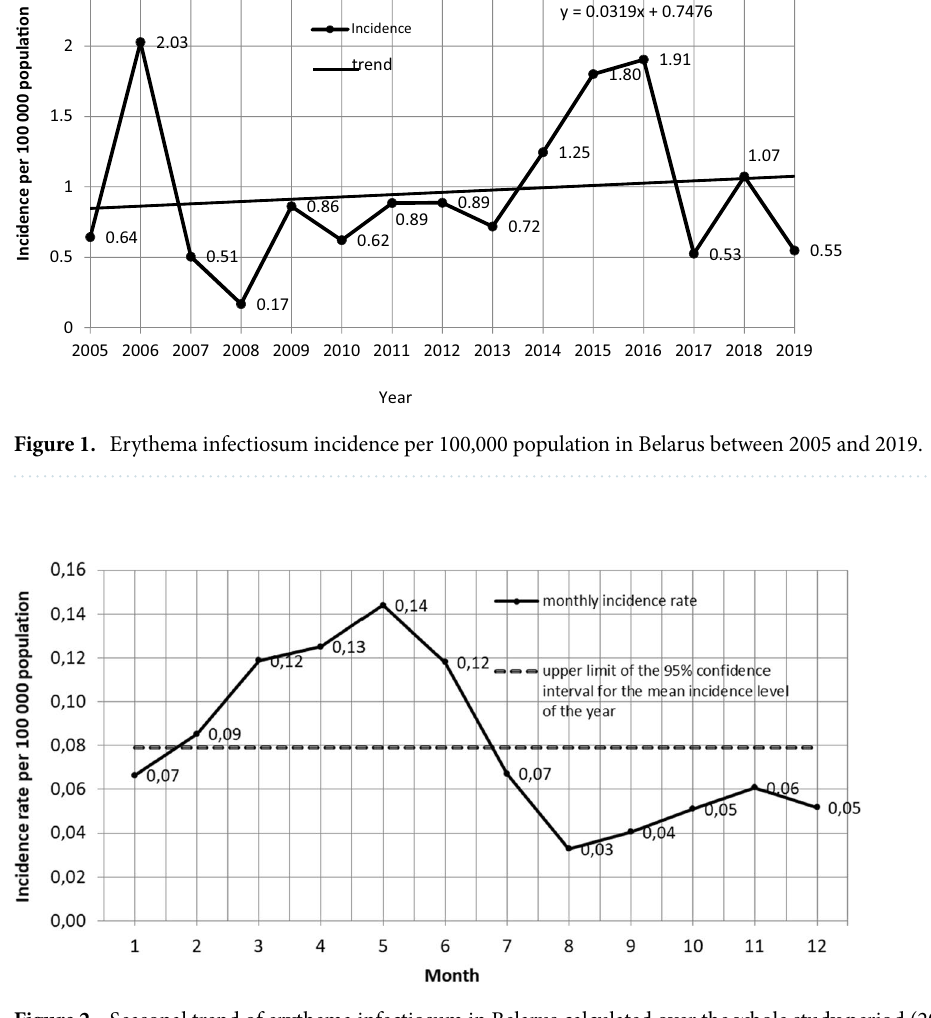
Figure 2. Seasonal trend of erythema infectiosum in Belarus calculated over the whole study period (2005– 2019).